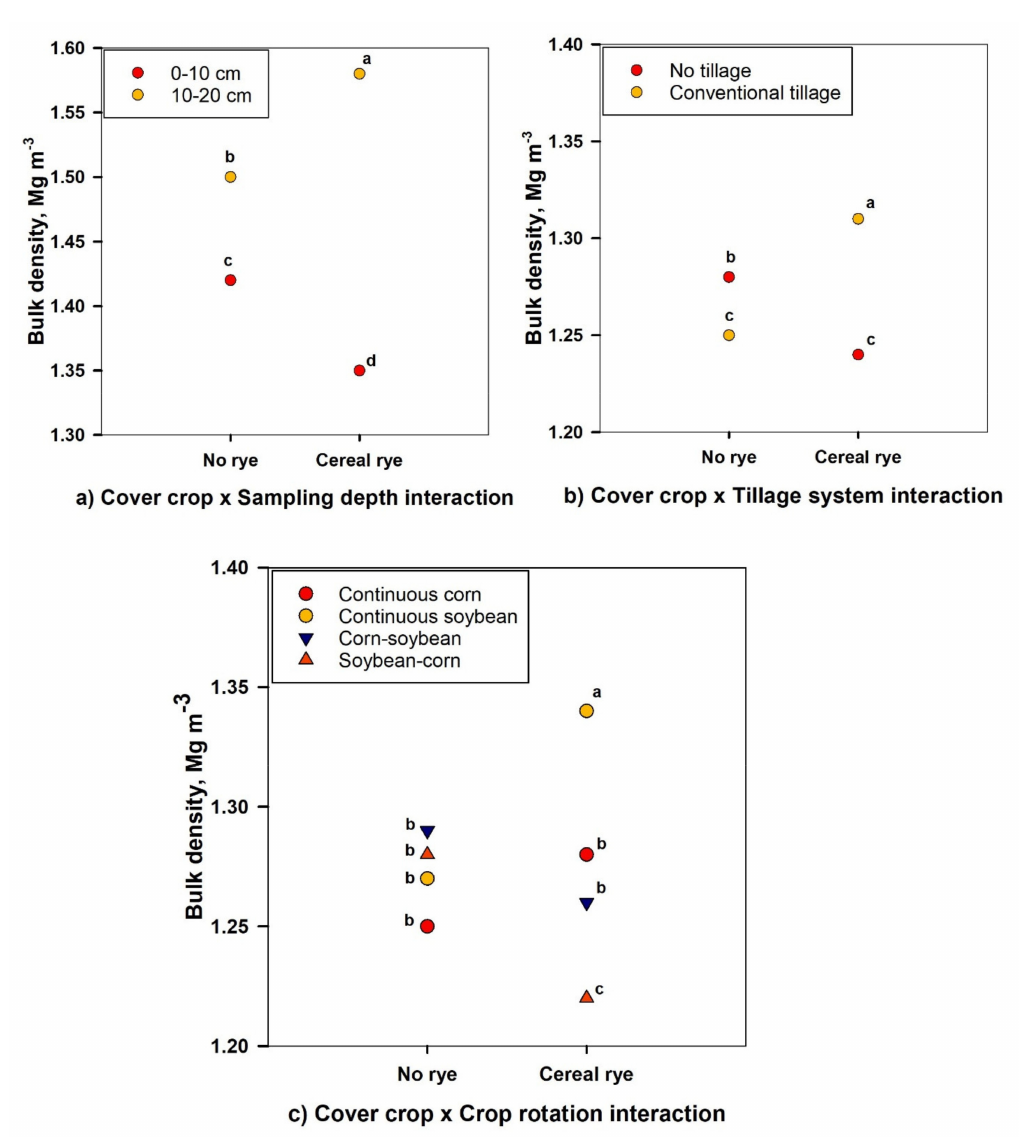
Figure 2. Interaction effect of different treatments on means of bulk density: ( a ) cover crop × sampling depth in 2012, ( b ) cover crop × tillage system and ( c ) cover crop × crop rotation in 2013. Means followed by the same lowercase letter are not significantly